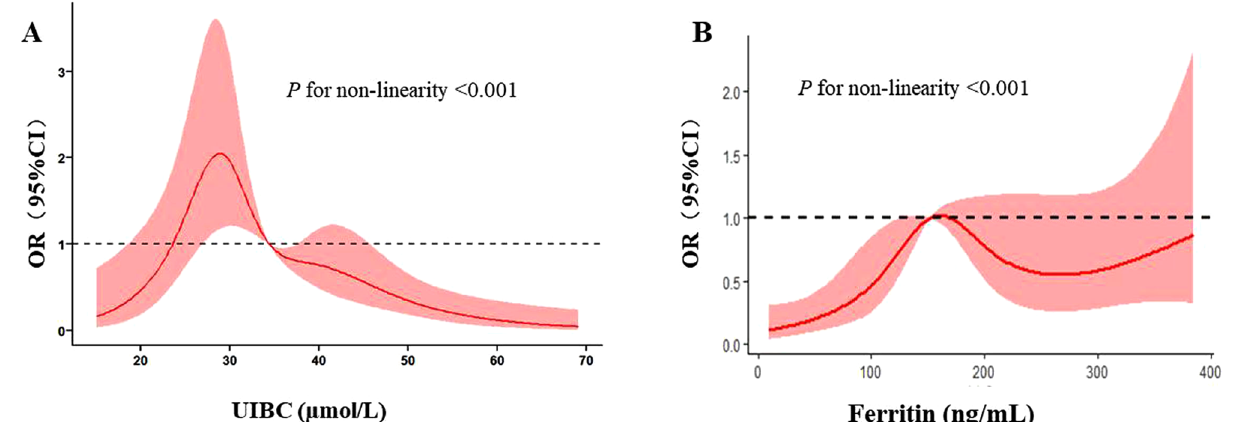
Figure 2. Spline model with four knots.